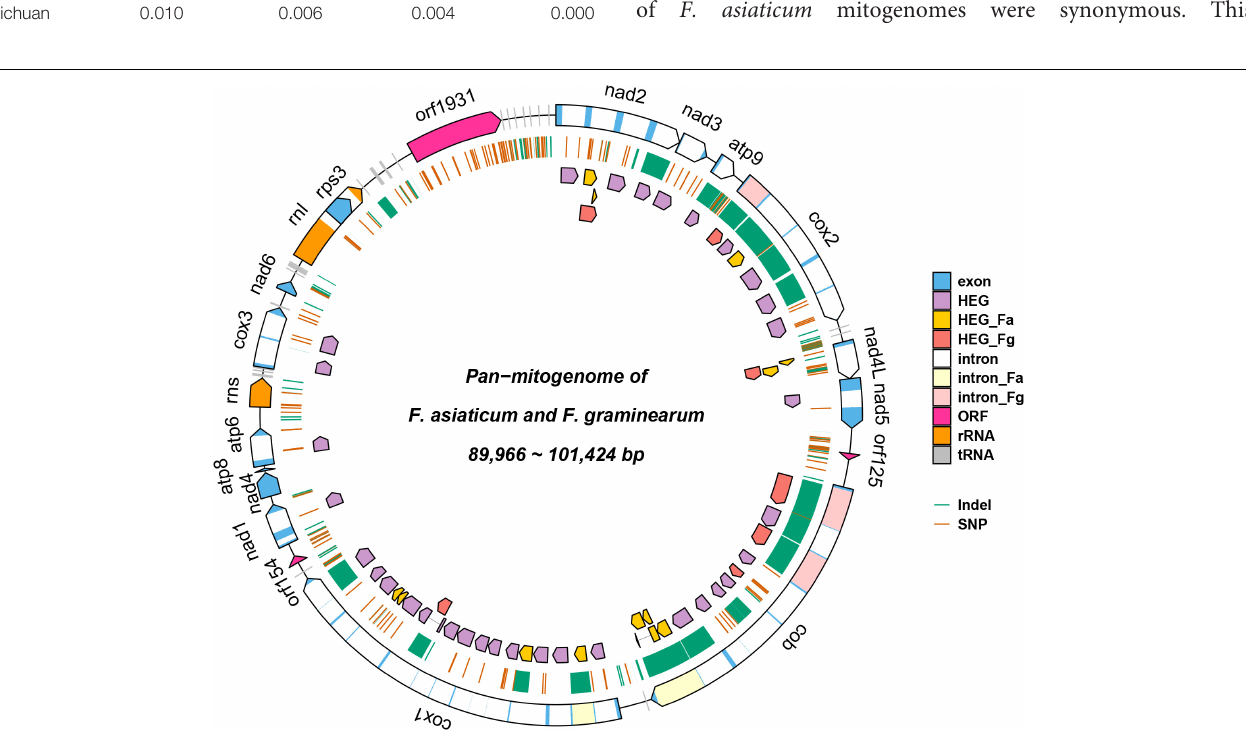
FIGURE 5 | Pan-mitogenome of 210 F. asiaticum and 24 Fusarium graminearum strains. HEG_Fa and HEG_Fg represent F. asiaticum and F. graminearum specific HEGs, respectively; intron_Fa and intron_Fg represent F. asiaticum and F. graminearum specific introns.